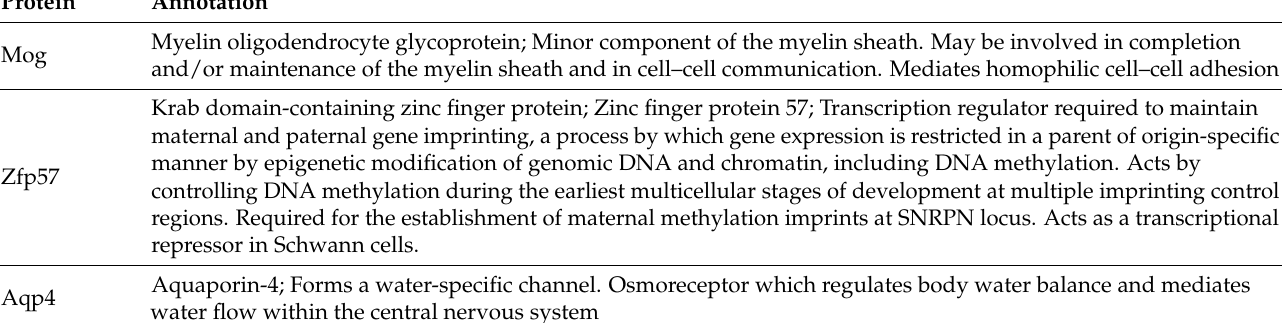
Table 7. Functional annotation of Mog protein association